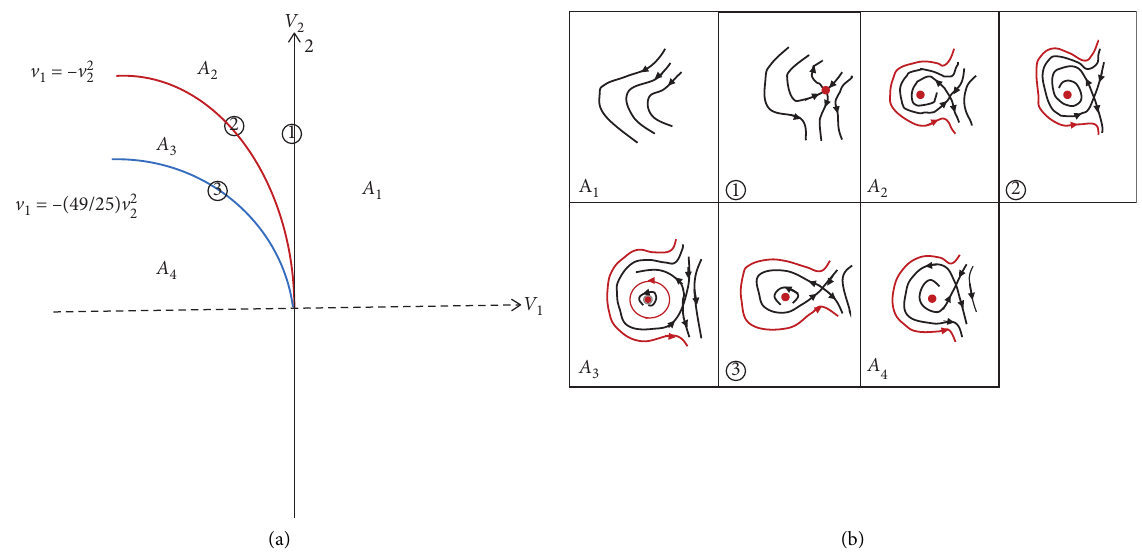
Figure 1: The bifurcation diagram (a) and phase portraits (b) of system (15) on the perturbation parameter v